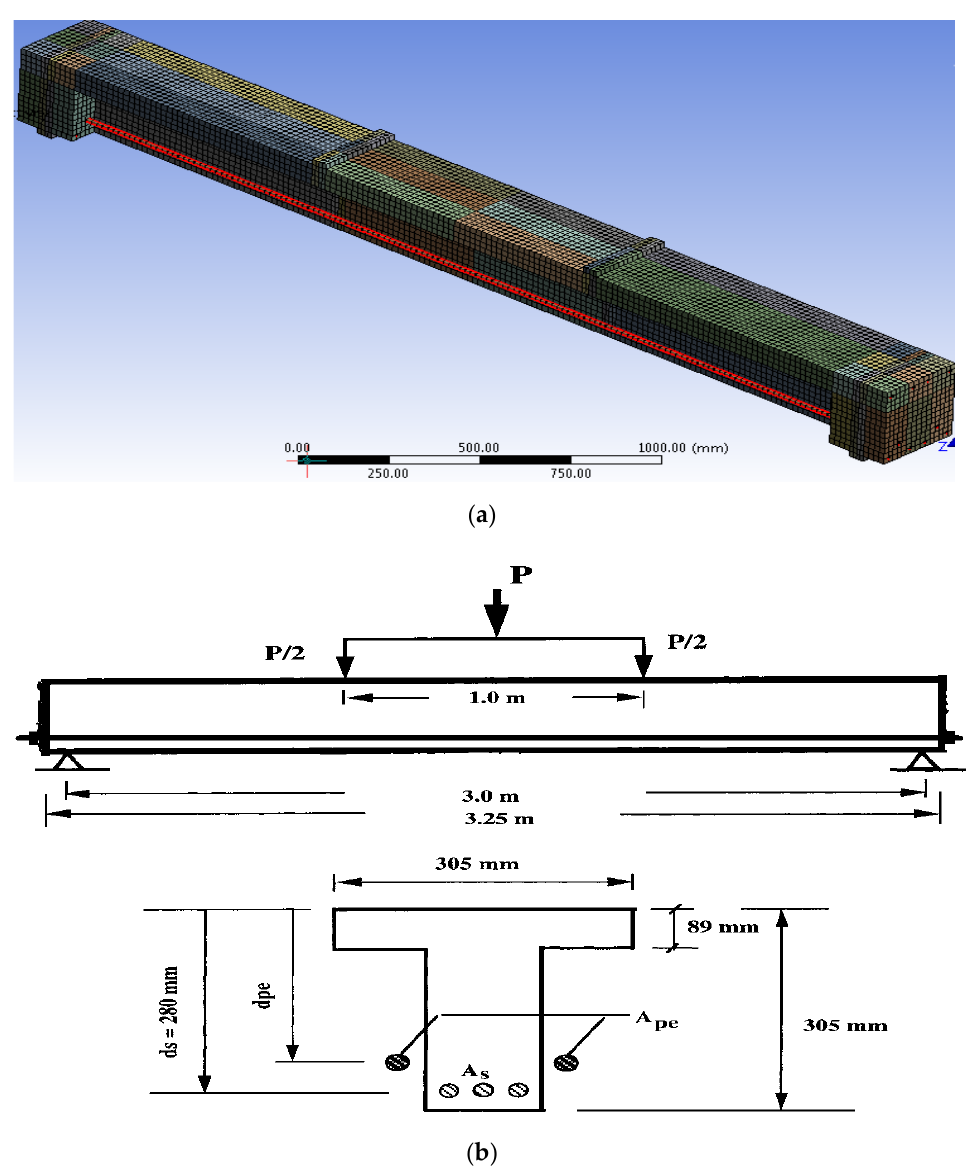
Figure 9. Loading method and external tendon profile: ( a ) FE; ( b ) experimental (Adapted from Ref. [26]). Table 2. Properties of the chosen beam specimens [26].